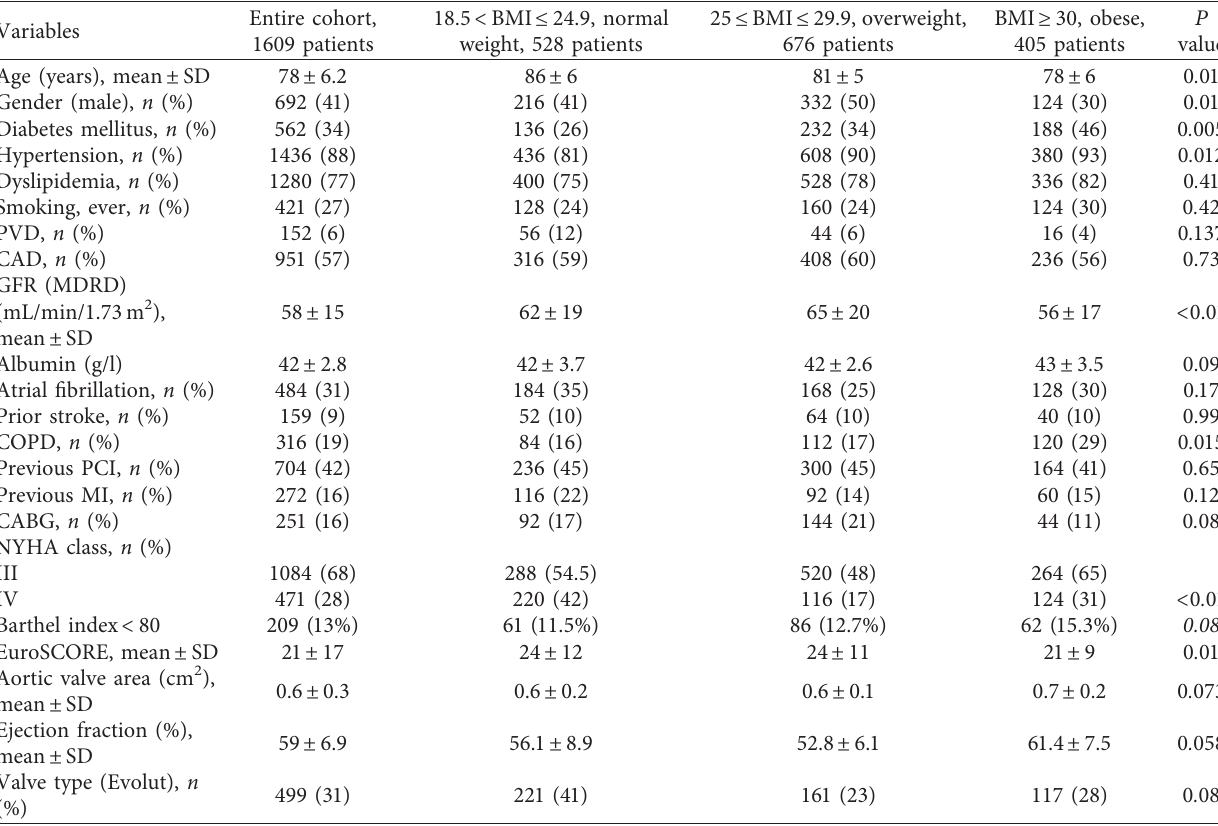
Table 1: Baseline clinical characteristics of patients according to BMI